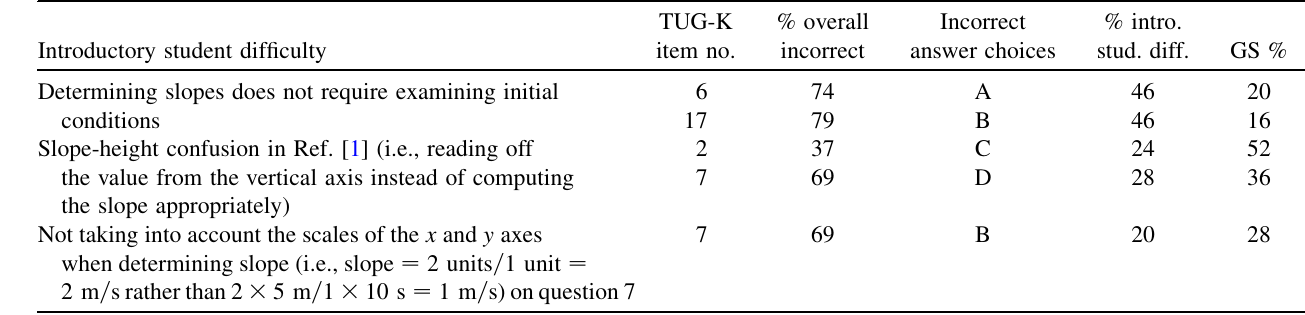
TABLE IV. Introductory student difficulties related to determining slopes, items on the TUG-K which uncover these difficulties (TUG-K item no.), percentage of introductory students who answer the items incorrectly (% overall incorrect), incorrect answer choices which uncover these difficulties, percentage of introductory students who have these difficulties based on their selection of these answer choices (intro. stud. diff.), and percentage of graduate students who select these answer choices as the most common incorrect answer choices of introductory students (GS %). For convenience, short descriptions of the questions are given underneath.